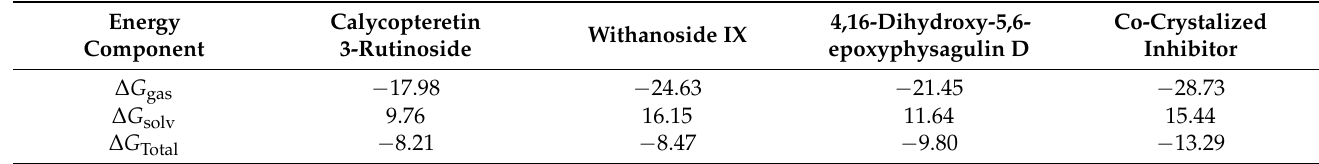
Table 3. Binding free energies (MM-PBSA) of top-scoring compounds along with the co- crystalized inhibitor in complex with NMT.